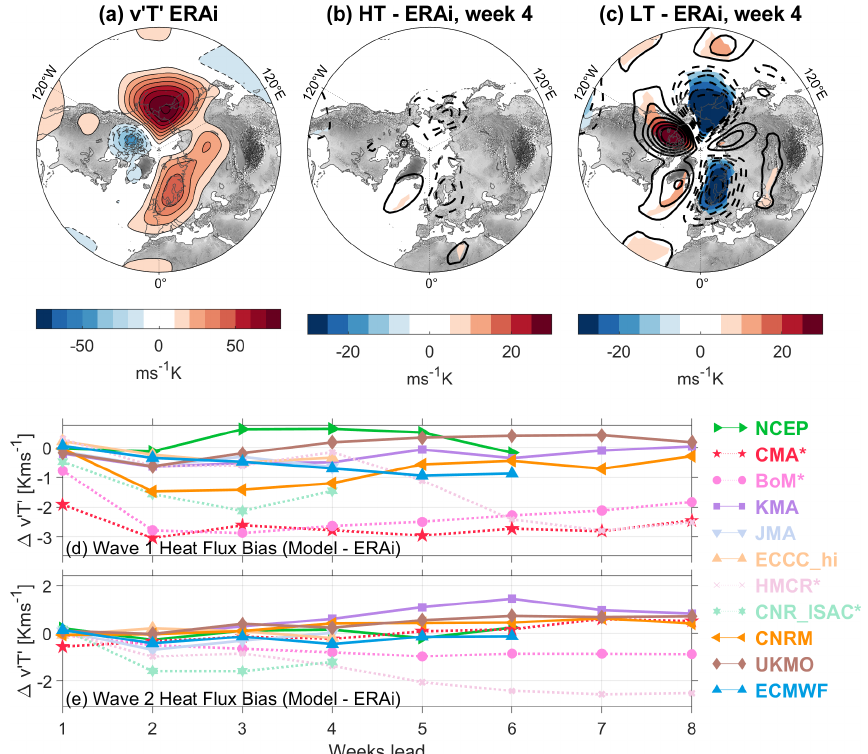
Figure 5. (a) The December–February climatology of ERA-I (“ERAi” in the figure) eddy heat fluxes, v (cid:48) T (cid:48) , at 100hPa. (b) The high-top composite of week-4 eddy heat flux biases with respect to ERA-I from November–January initializations. Panel (c) is as in (b) but composited for the low-top models. In panel (a) , the line and color-filled contours match the color-bar spacing of 10Kms − 1 ; in panels (b) and (c) , the line contours match the color-bar contour intervals of 5Kms − 1 , but colors are only shown where the biases are statistically significant at the 95% level from a two-tailed Student’s t test. (d) Time series of the difference between the S2S hindcasts and ERA-I for the wave-1 eddy heat flux averaged over 45–75 ◦ N for lead times from 1 to 8 weeks. Panel (e) is as in (d) but for wave